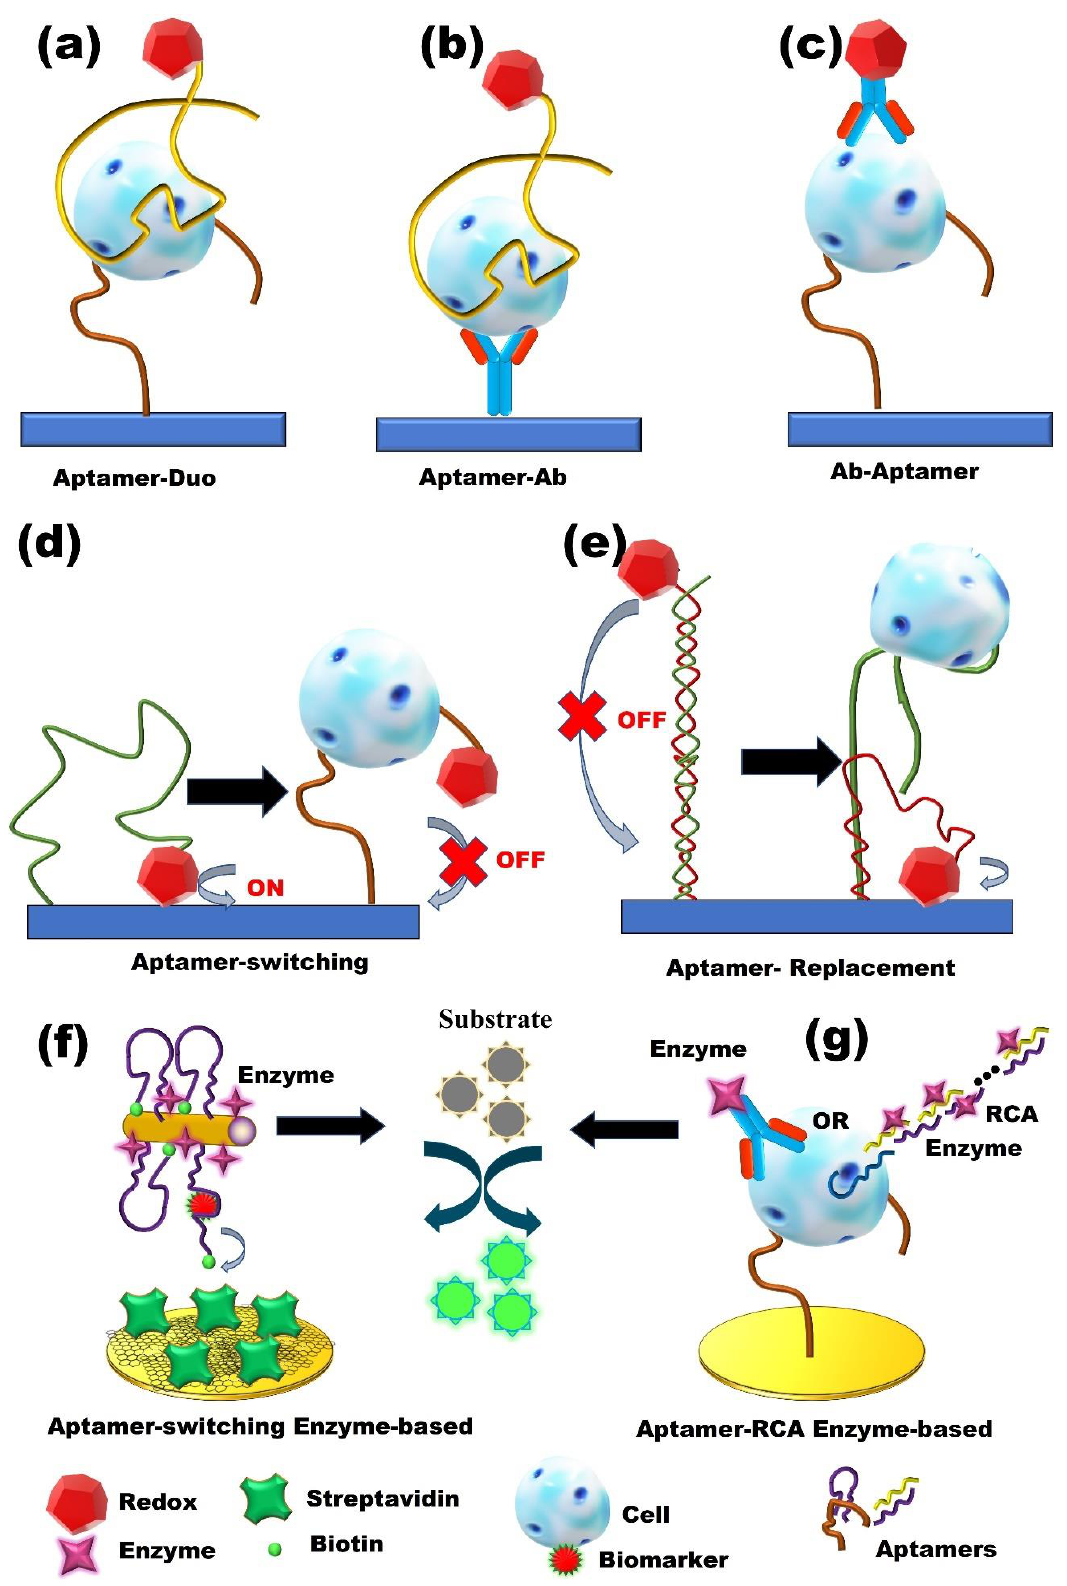
Figure 1. Label-based electrochemical aptasensor. ( a ) The redox-active label Aptamer – Aptamer Duo strategy. ( b , c ) The redox-active label Aptamer – Antibody strategies. ( d , e ) The redox-active label Aptamer-switching and replacement strategies. ( f , g ) Enzyme-based label electrochemical aptasensor strategies. Ab: antibody, RCA: rolling circle